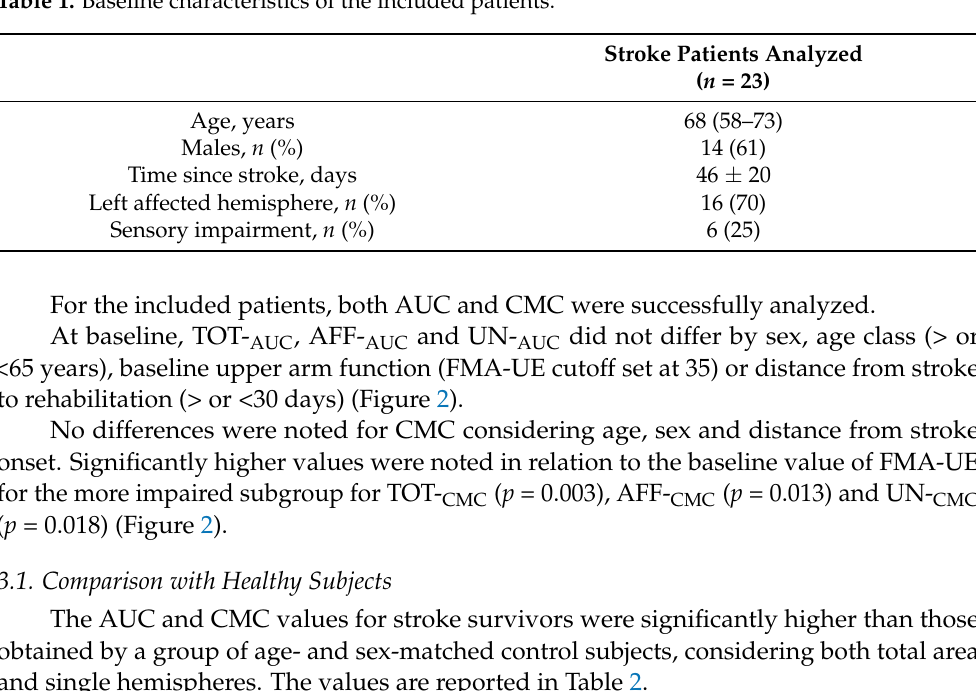
Table 1. Baseline characteristics of the included patients.